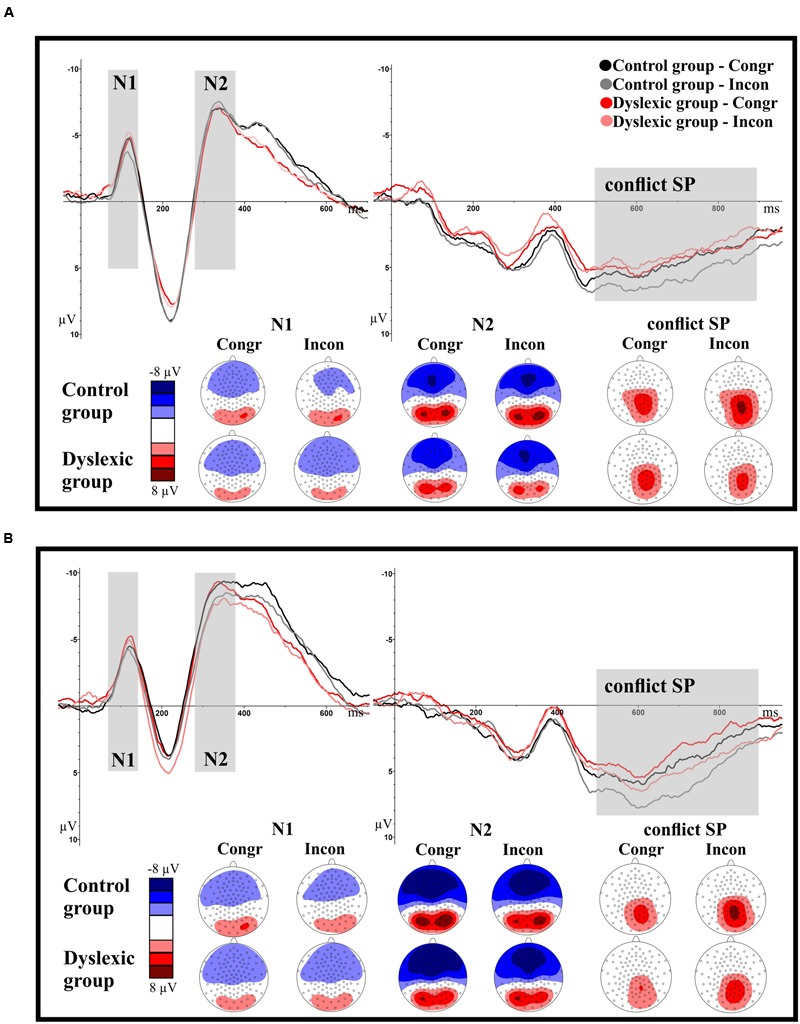
Illustration of the grand-average ERP waveforms depicted separately for the fronto-central (N1, N2) and the parietal ROIs (cSP) and the letter-speech sound interference and visual interference experiments. The time windows selected for the components N1 (70–140 ms), N2 (280–380 ms) and cSP (500–900 ms) are highlighted in gray. Negativity is depicted upward. (A) ERP components (averaged per group and condition) in the letter-speech sound interference experiment. (B) ERP components (averaged per group and condition) in the visual interference experiment.